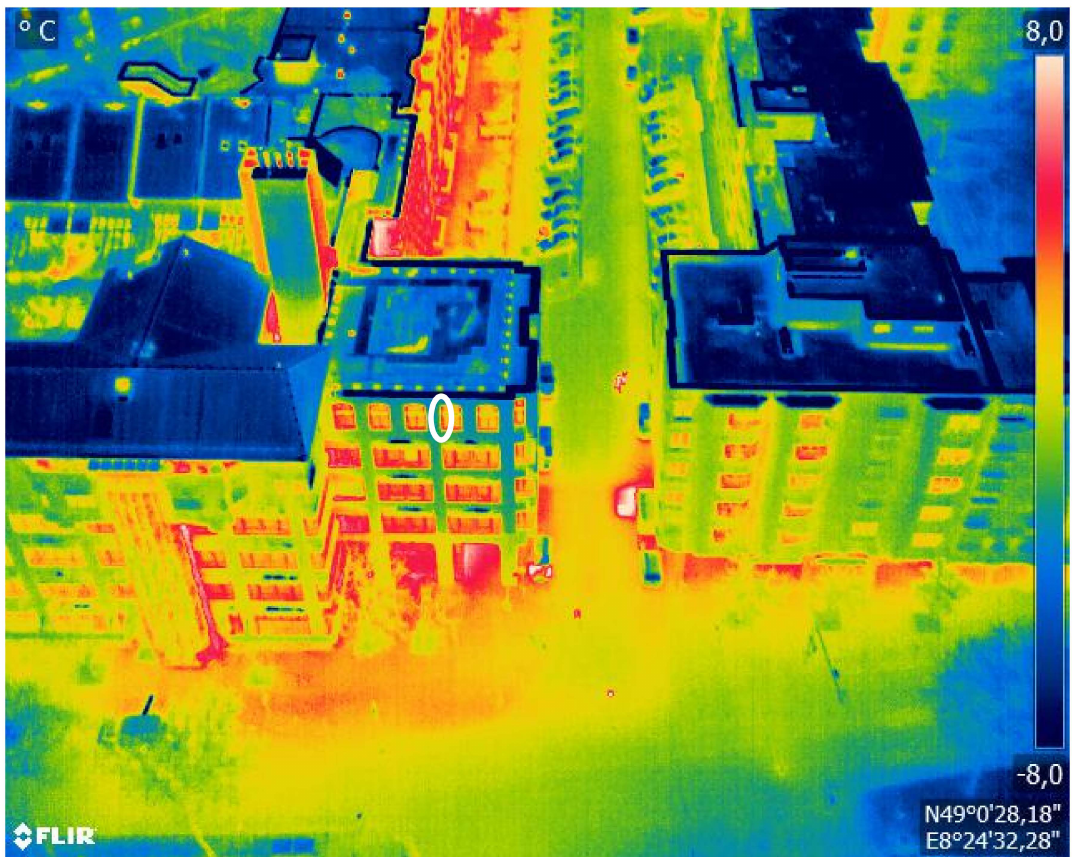
Figure A13. Example: thermal bridge of a window reveal.